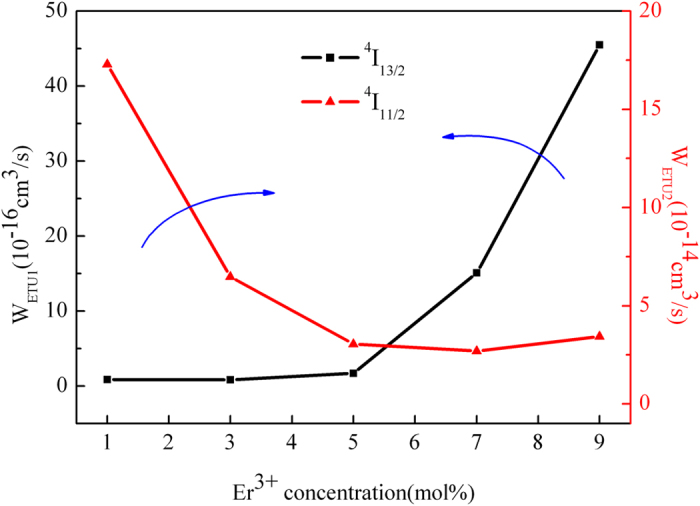
Fitting results of parameters WETU with different Er3+ doping concentration.